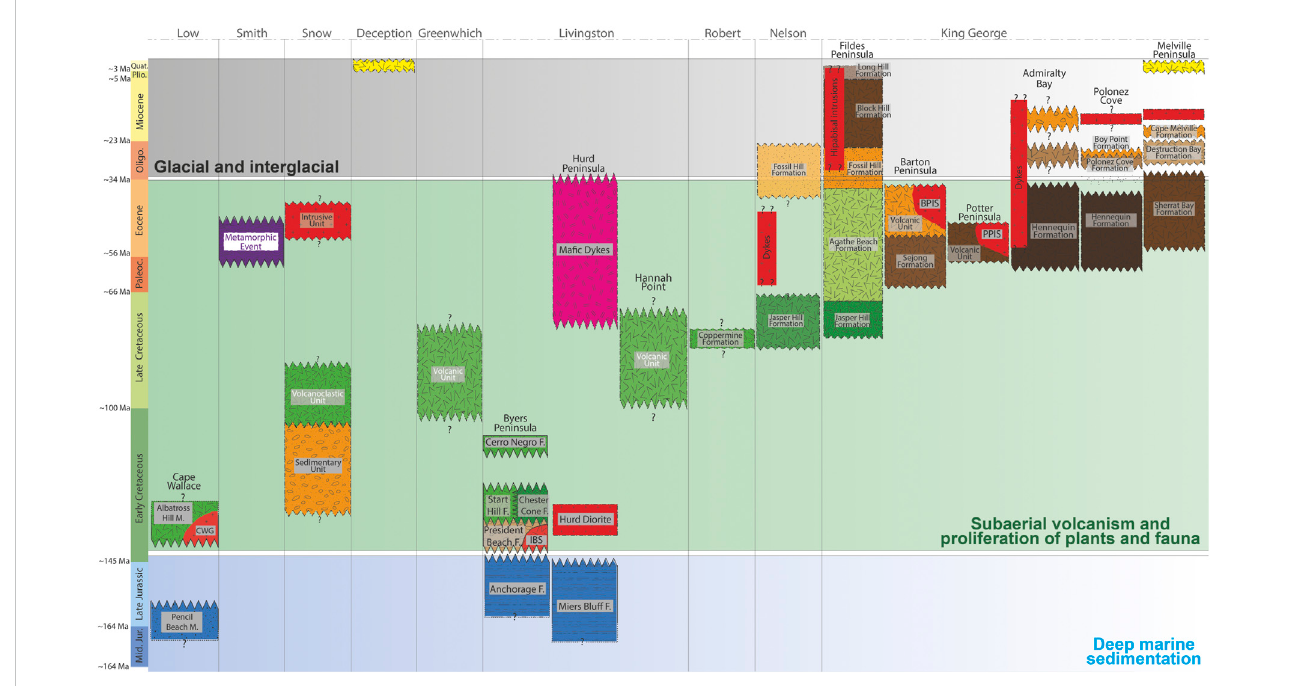
FIGURE 15 MajorlithostratigraphicunitsoftheSouthShetlandIslands.Threemaintectonostratigraphicepisodesarerecognised:1)deepmarinesedimentationfrom ~164 to 140 Ma, 2) subaerial volcanism and proliferation of plants and fauna from ~140 to 35 Ma and 3) glacial and interglacial with sedimentation and volcanism from ~35